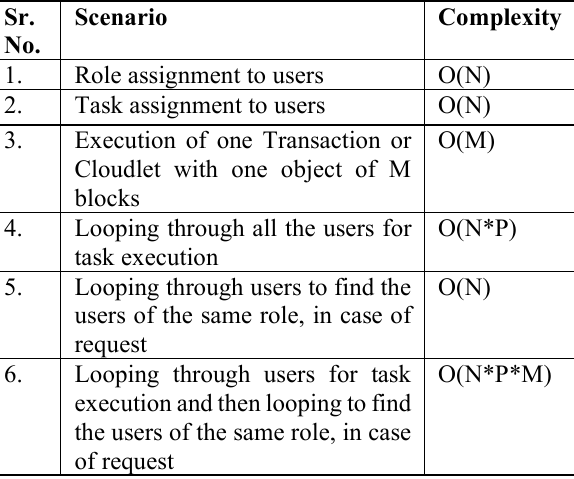
Table 1. Complexity analysis for EF-RBAC